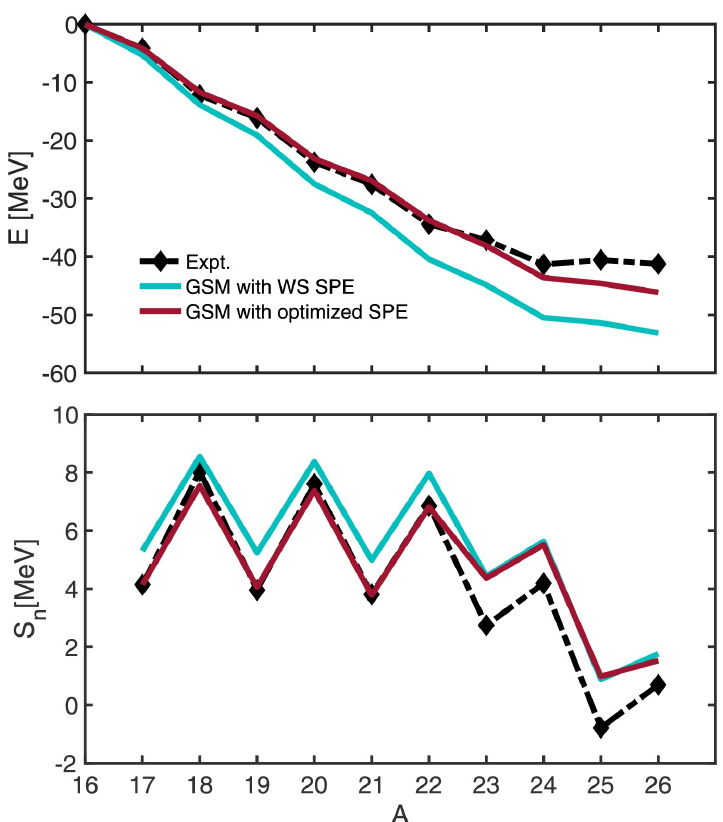
Figure 3. Calculated ground state energies of oxygen isotopes with respect to the 16 O core (upper panel) and associated neutron separation energies S n (lower panel) as a function of atomic number compared with experimental data [8,74,78]. “GSM with WS SPE” indicates that the calculations were performed with Woods-Saxon (WS) single-particle energies (SPE), whereas “GSM with optimized SPE” means that the calculations were performed with the 0 d 5/2 SPE replaced by its experimental value (with permissions from Ref.